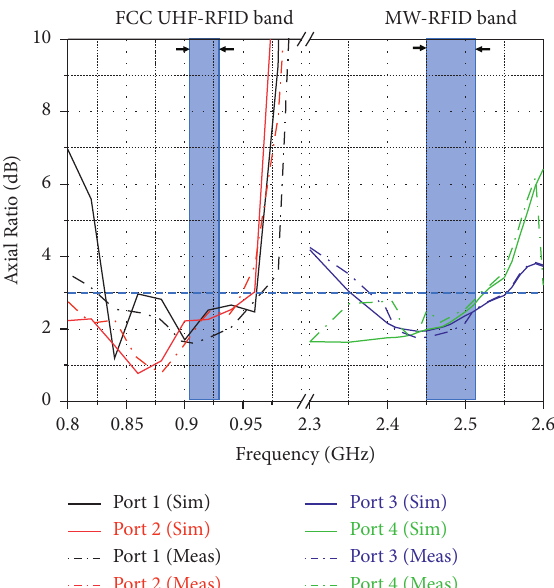
Figure 11: Simulated and measured axial ratio.